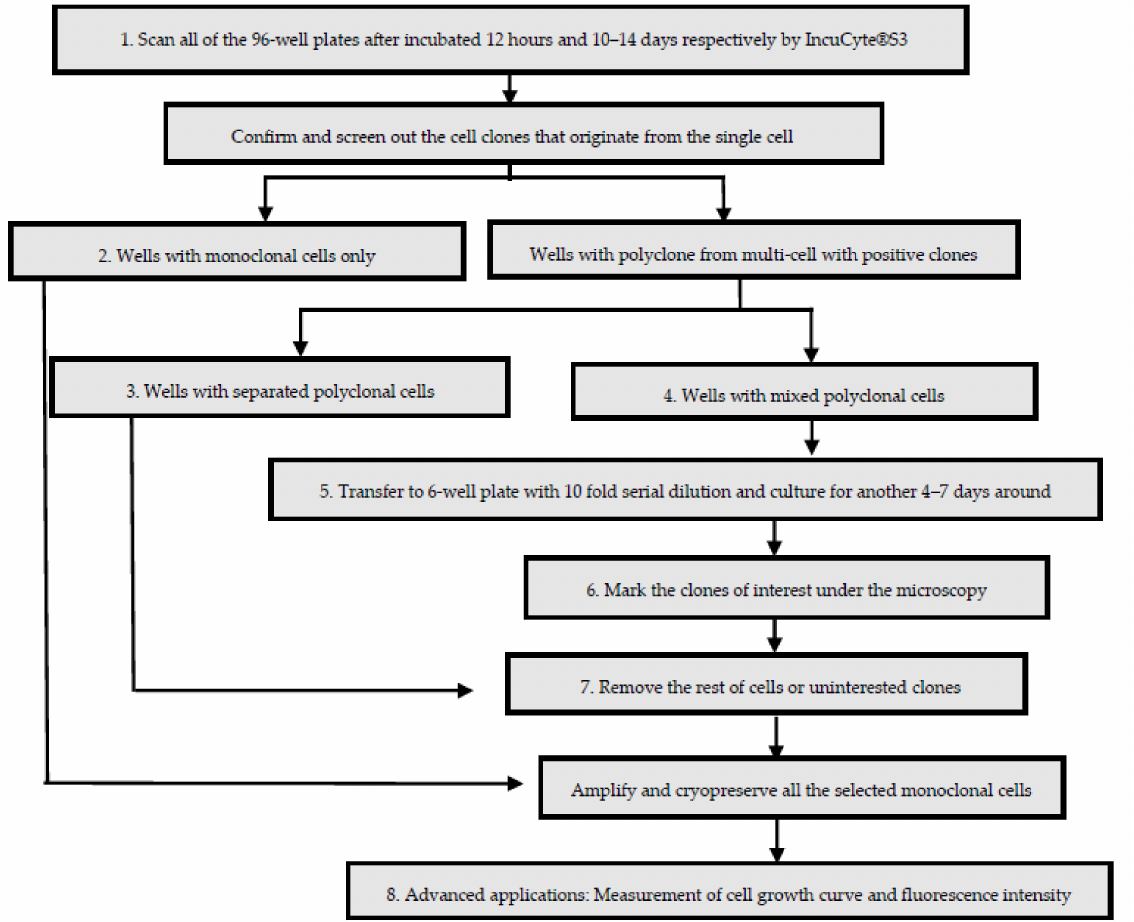
Figure 3. Workflow of monoclonal cells selection after lentivirus infection.